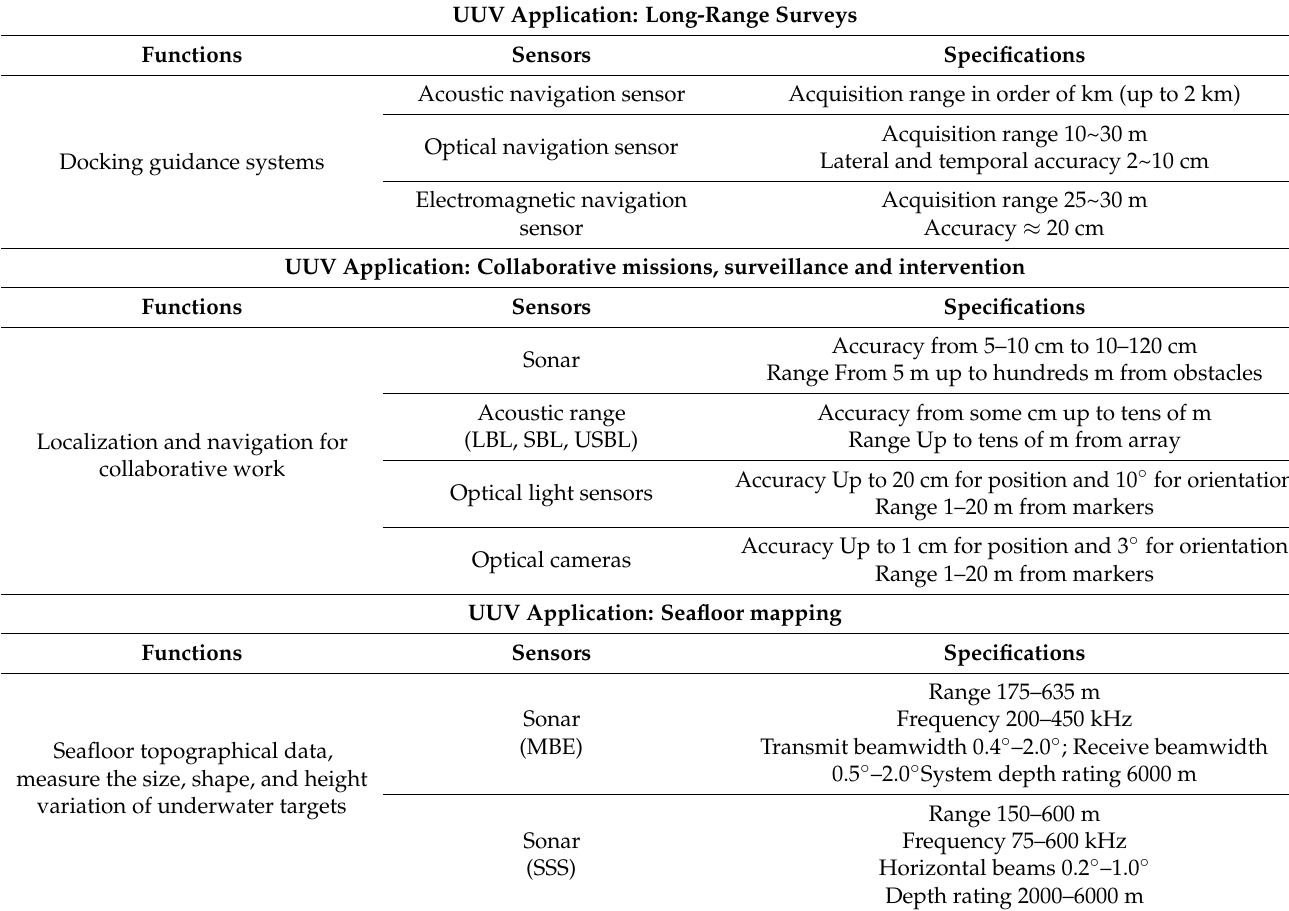
Table 8. Some examples of UUV sensor application